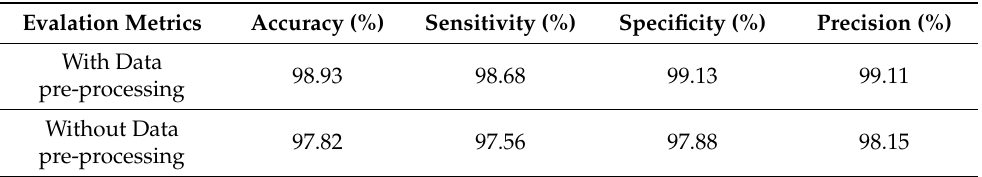
Table 6. Comaprative analysis of the results obtianed by the Proposed Transfer Learning based DCNN Model on Figshare dataset with and without data